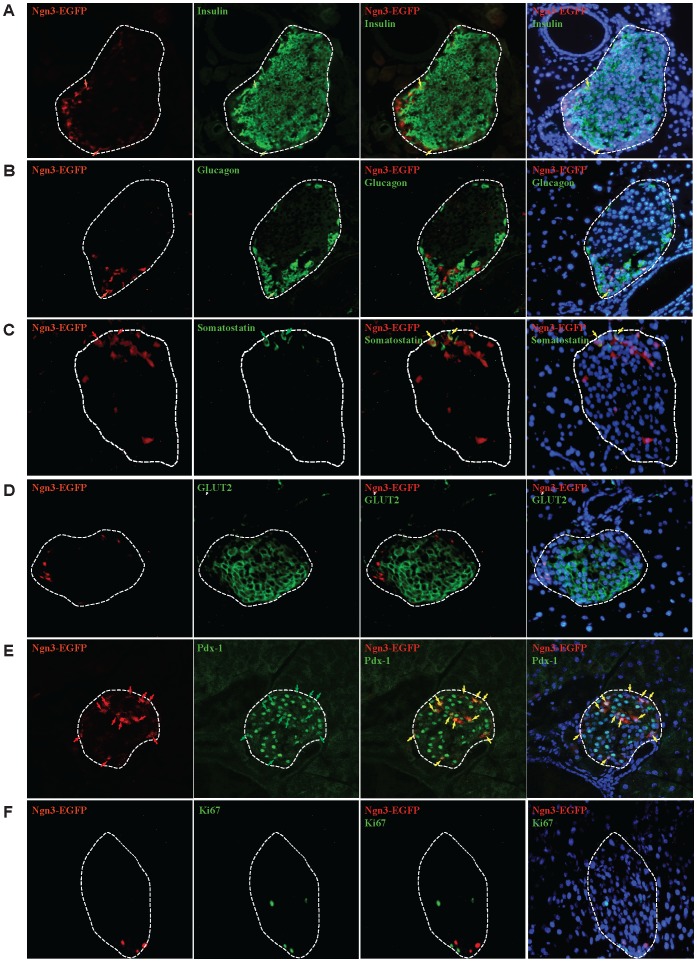
Co-expression of Ngn3 with insulin, glucagon, somatostatin, GLUT2, Ki67, or Pdx-1 in pancreatic islets.Representative images from G8 Ngn3EGFP/+ mice are shown immunostained for Ngn3, identified by EGFP-positivity (red), and either insulin (green), glucagon (green), somatostatin (green), GLUT2 (green), Pdx-1 (green), or Ki67 (green) staining. Islets are outlined in white. Red arrows points to Ngn3-EGFP+ cells, green arrows points to hormone-positive cells, yellow arrows points to Ngn3-EGFP+ cells that co-localizes with either a hormone, GLUT2, Pdx-1 or Ki67.